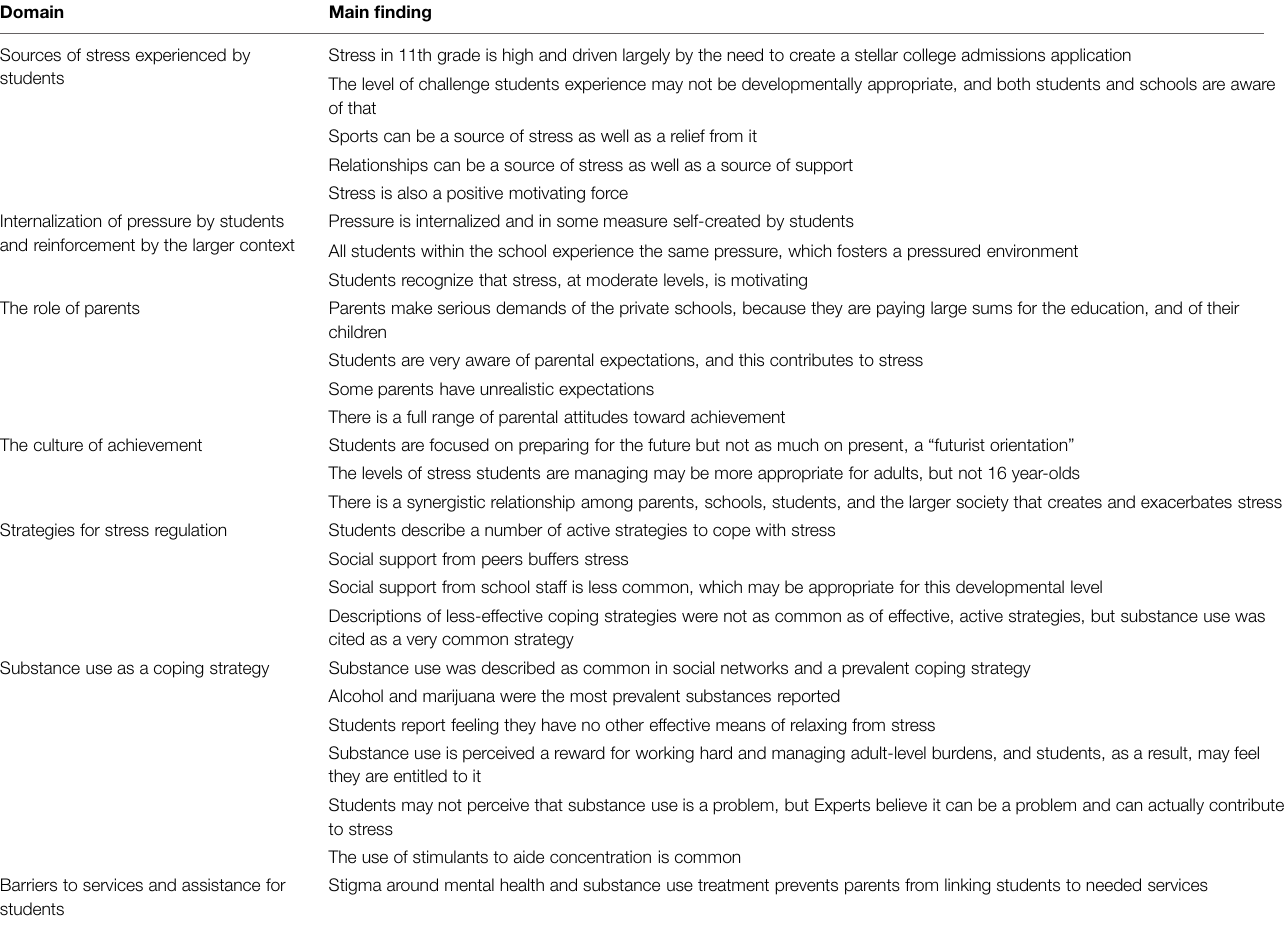
TABLE 3 | Summary of qualitative